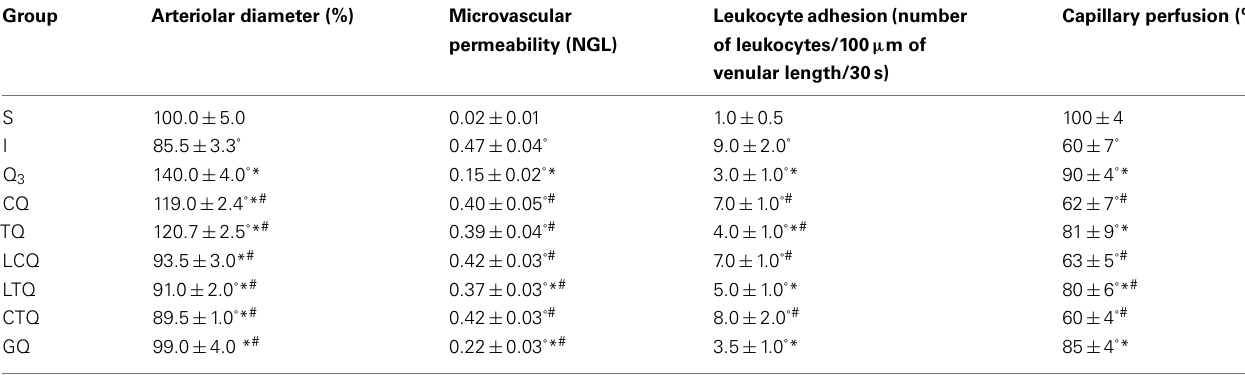
Table 2 |Variations of the main parameters in sham-operated (S) group, ischemic (I) group, quercetin (Q 3 ) group (5mg/Kg b.w.), chelerythrine plus quercetin (CQ) group, tyrphostin 47 plus quercetin (TQ) group, L-NAME and chelerythrine plus quercetin (LCQ) group, L-NAME and tyrphostin 47 plus quercetin (LTQ) group, chelerythrine and tyrphostin 47 plus quercetin (CTQ) group, glibenclamide plus quercetin (GQ) group at the end of